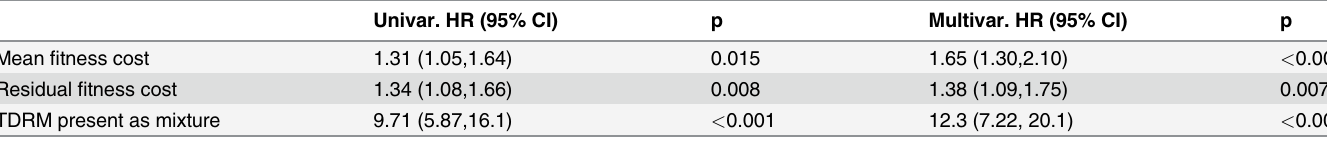
Table 2. Hazard ratios (HR) reported in univariable and multivariable